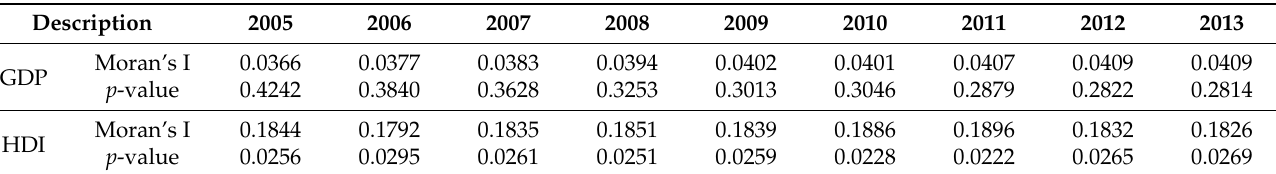
Table 2. Testing results of Global Moran’s